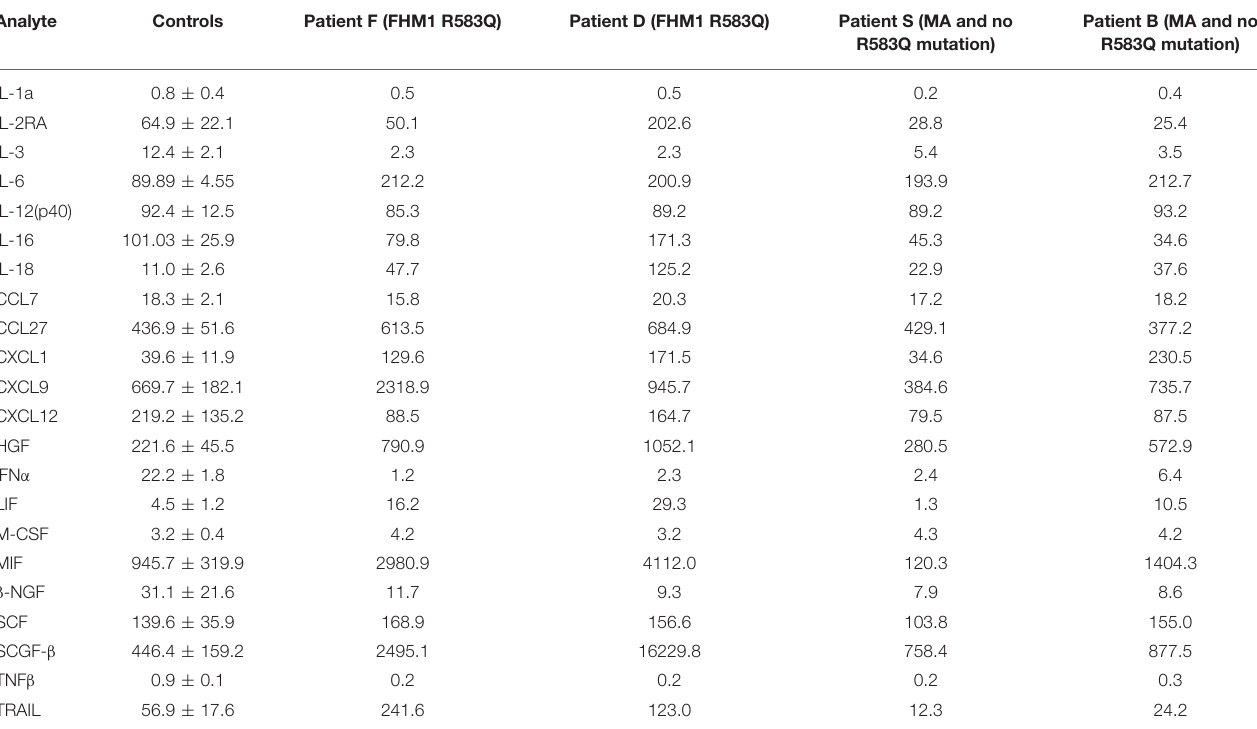
TABLE 1 | Serum cytokines in patients diagnosed with migraine. Analyte Controls Patient F (FHM1 R583Q) Patient D (FHM1 R583Q) Patient S (MA and no